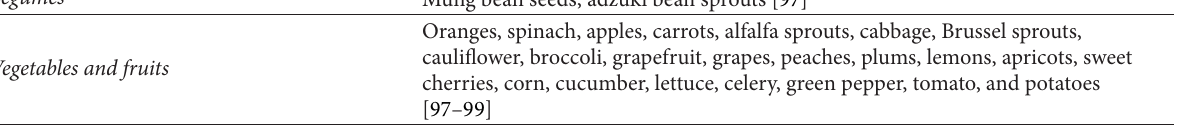
Table 5: (a) Human and in vivo example nutrient inducers of UGT enzymes. (b) Selected dietary sources of D-glucaric acid. Food, beverage, or bioactive Enzyme